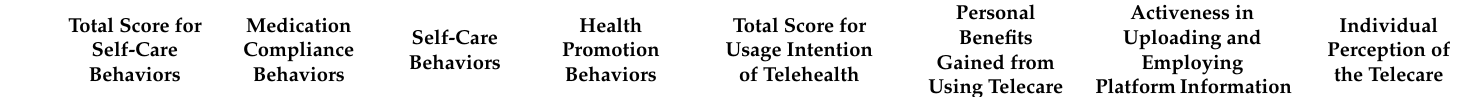
Personal Activeness in Individual Benefits Uploading and Perception of Gained from Employing the Using Telecare Platform Information